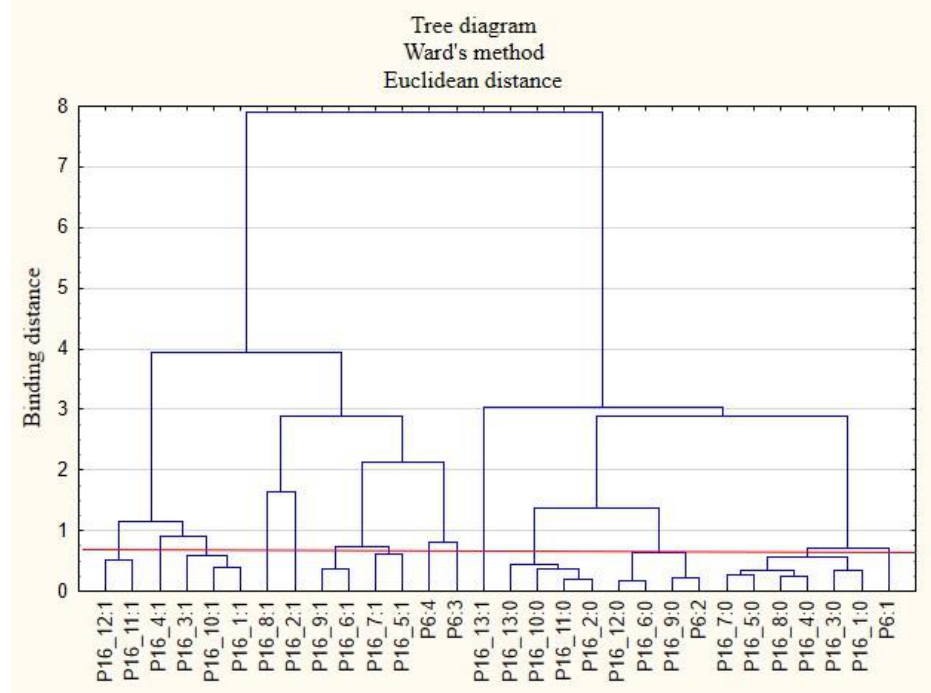
Figure 11. Diagram of hierarchical classification of variable categories: support that respondents want to receive after the end of the COVID-19 pandemic from the employer in the area of healthcare and the effective use of the benefits offered (P16) as well as the positions the respondents work in (P6).